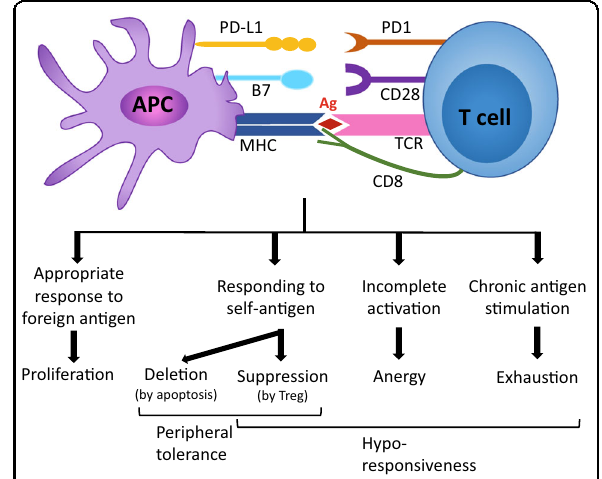
Fig. 1 Hyporesponsiveness of CD8 + T cells. Naïve cytotoxic CD8 +